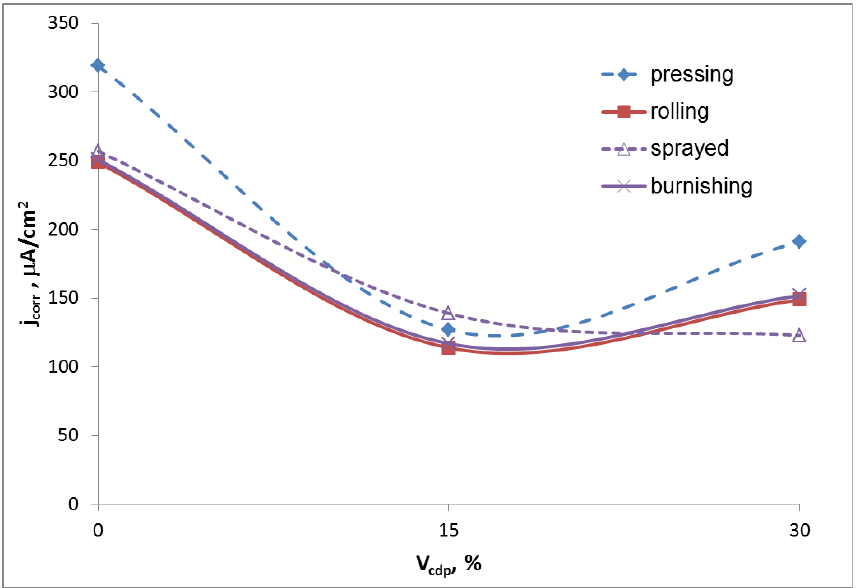
Figure 4. The influence of the volume fraction ceramic dispersed phase in the composite coatings on corrosion current density after pressing, rolling, burnishing and flame spraying.